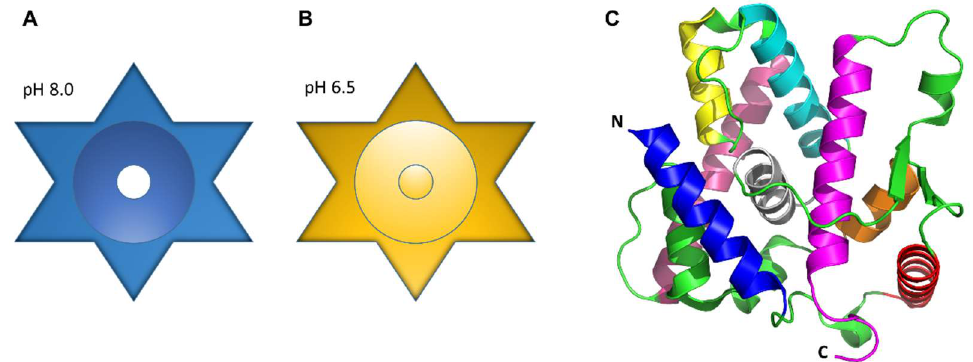
Figure 5. Three-dimensional architectures of human LETM1 and yeast MDM38. ( A ) The plan (top) view of the recombinant human LETM1 hexamer at pH 8.0 showing an open cavity at the center. ( B ) The plan (top) view of the recombinant human LETM1 hexamer at pH 6.5 showing the central cavity blocked at pH 6.5. ( C ) Ribbon representation of the backbone structure of the C-terminal MDM38 14-3-3-like domain spanning residues 182–408. The crystal structure was resolved at 2.1 Å. The human LETM1 architecture shown in ( A , B ) was determined by negative stain electron microscopy, and the shapes are interpretations of the low resolution EM structures shown by Shao and co-workers [61]. The structure in ( C ) was generated using the 3SKQ.pdb coordinates [102] in PyMOL.